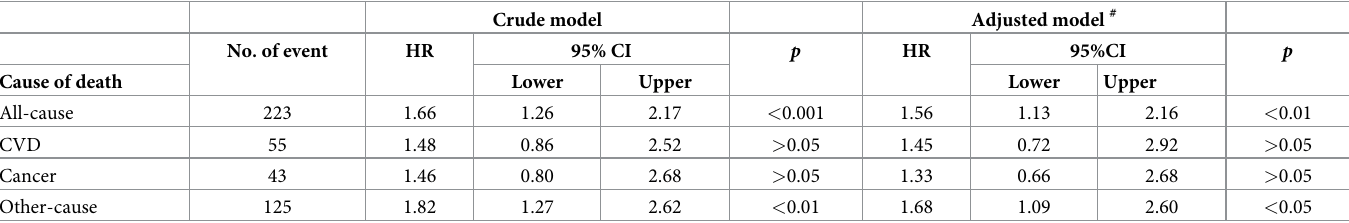
Table 2. All-cause and cause-specific mortality risk in individuals with lower dietary magnesium intake ( � 250 mg/day) compared with higher dietary magnesium intake ( > 250 mg/day). Crude model Adjusted model